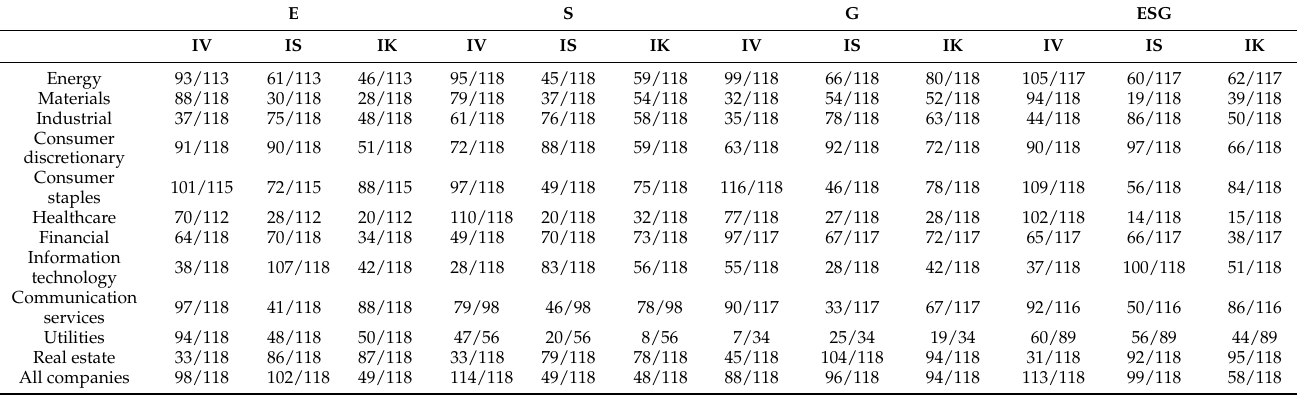
Table 5. Number of months during which companies in the high ESG rating group have better performance than those in the low ESG rating group. Group-dividing standards are the 0.4 and 0.6 percentiles of ESG